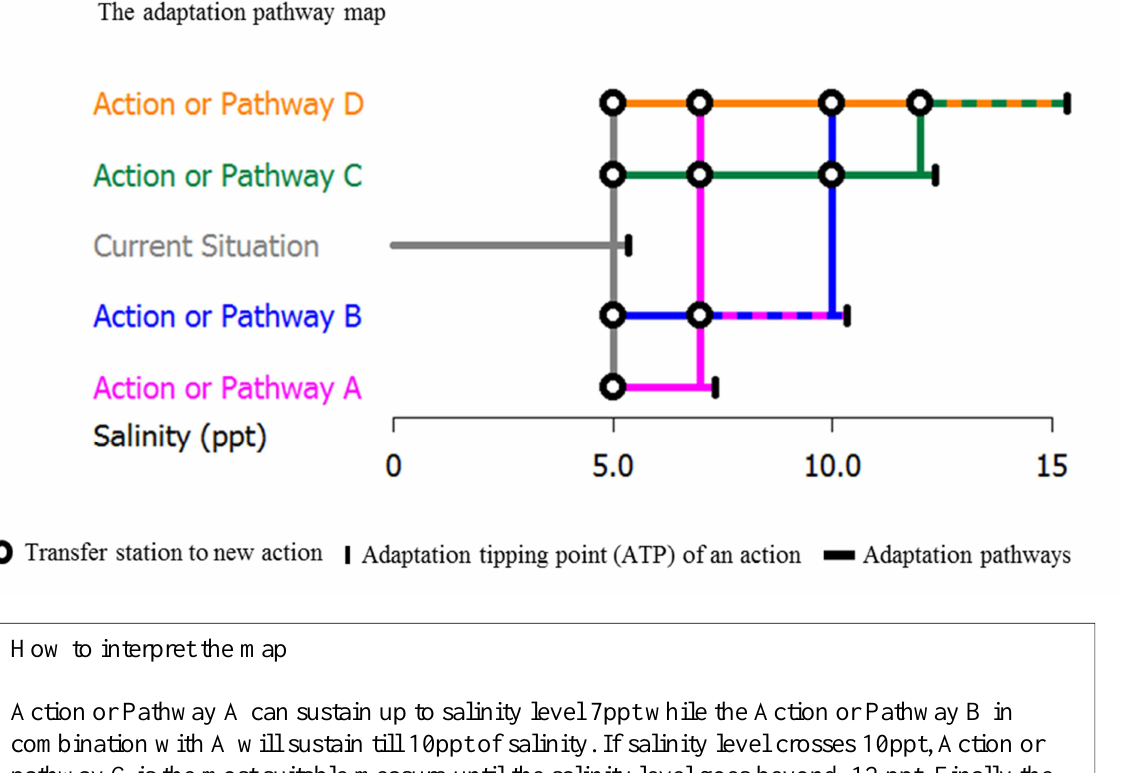
How to interpret the map Action or Pathway A can sustain up to salinity level 7ppt while the Action or Pathway B in combination with A will sustain till 10ppt of salinity. If salinity level crosses 10ppt, Action or pathway C is the most suitable measure until the salinity level goes beyond 12 ppt. Finally the Action or pathway D combined with Action C are expected to sustain up to 15 ppt of